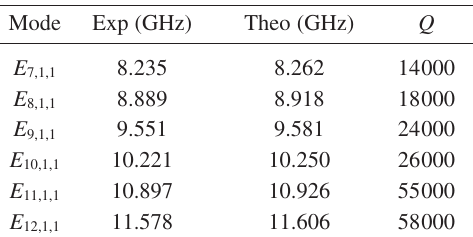
Table I. Experimental and theoretical resonance frequencies of a Sapphire Dielectric Resonator made of two disks of 42 mm diameter and 5 mm height in contact.